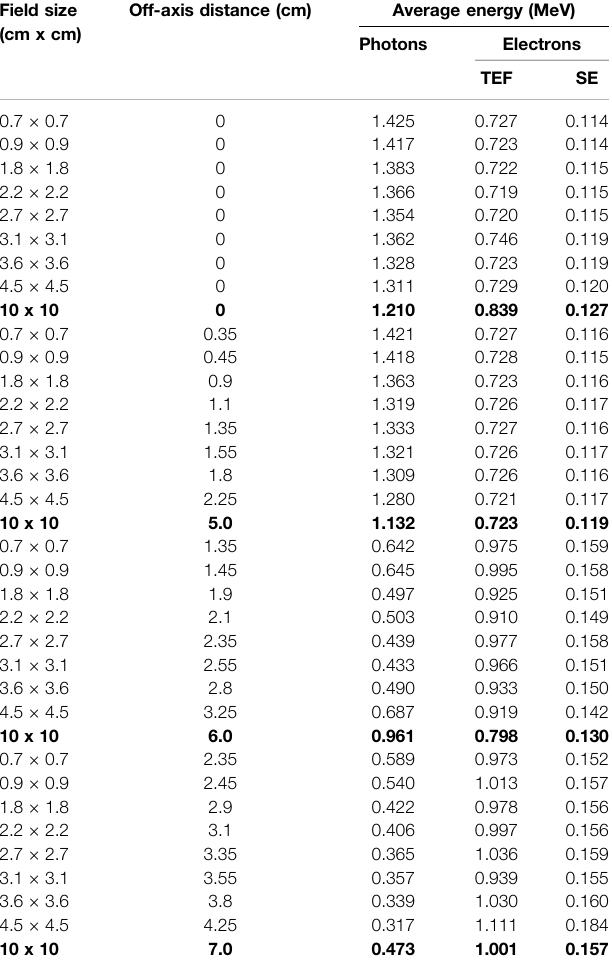
The bold indicates the end of each distance from the edge of the fi elds.